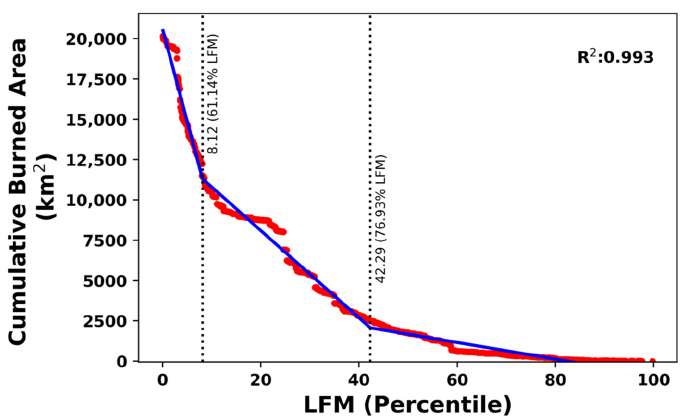
Figure 4. LFM of predicted LFM percentiles vs. cumulative area burned. Dashed lines indicate calculated locations of thresholds between LFM domains (measured both as LFM percentile rank and actual LFM).